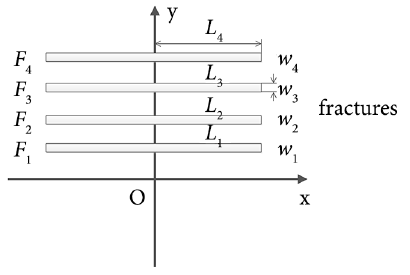
Figure 7. Schematic diagram of fracture distribution